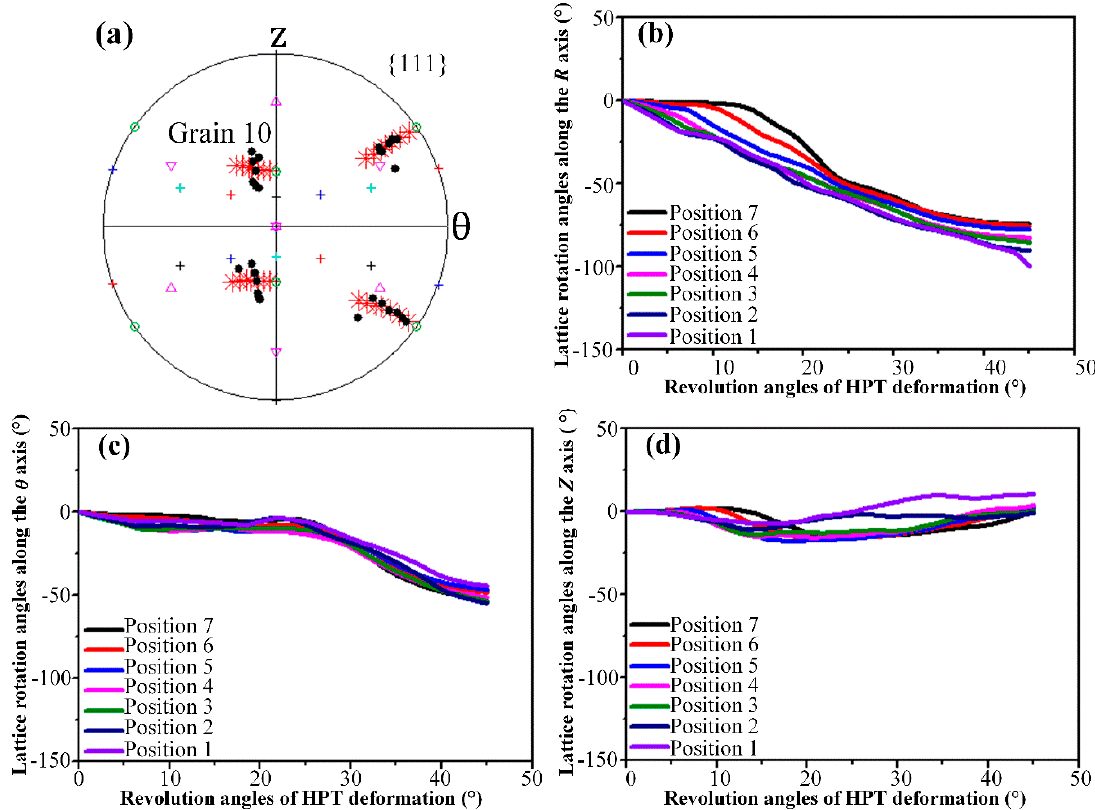
Figure 9. The predicted results for various thickness positions of Grain 10. ( a ) {111} pole figure, ( b ) lattice rotation angles along the R axis, ( c ) lattice rotation angles along the θ axis and ( d ) lattice rotation angles along the Z axis.